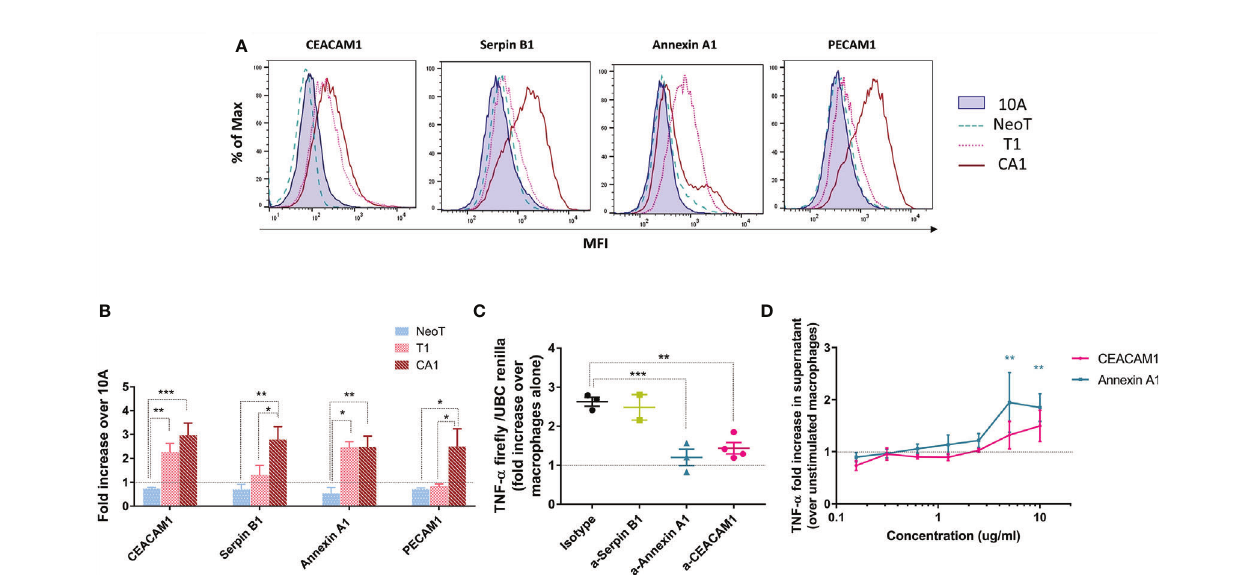
FIGURE 5 | Candidate danger molecules differentially expressed above and below the macrophage activation threshold that promote in fl ammatory function. (A) Representative fl ow plots of CEACAM1, Serpin B1, Annexin A1 and PECAM1 expression in MCF10A (10A), MCFNeoT (NeoT), MCFT1(T1) and MCFCA1 (CA1). (B) Differential expression of selected cell surface proteins by MCFNeoT (NeoT), MCFT1 (T1) and MCFCA1 (CA1) relative to MCF10A (10A, dashed line), assessed by fl ow cytometry. Results are presented as mean values ± SEM of three experiments. Fisher LSD test: ***p<0.001, **p<0.01. (C) Fold increase of TNF- a expression in macrophages co-incubated for 24h at a ratio of 1 macrophage to 5 MCFT1 cells, preincubated for 30 min with either an isotype control antibody or antibodies against Serpin B1 (yellow), Annexin A1 (blue) and CEACAM1 (pink). Results are presented as mean values ± SEM of two to four experiments. Fisher LSD test: **p<0.01, *p<0.05. (D) Fold increase in TNF- a production in macrophages stimulated with different concentrations of Annexin A1 and CEA proteins for 24h compared to unstimulated macrophages, as assessed by ELISA. Results are presented as mean values ± SEM of three experiments. Fisher LSD test: